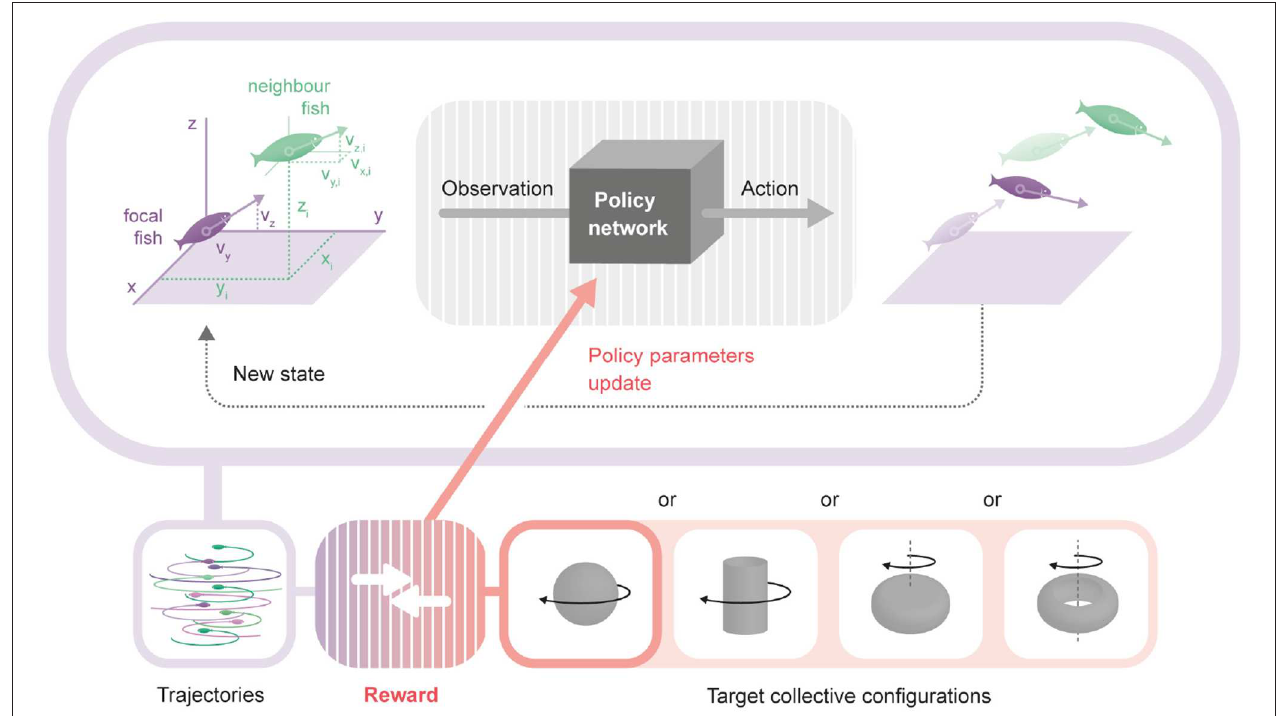
FIGURE 1 | Framework to obtain an interaction model producing a desired collective behavior. Upper: The policy network is a neural network that transforms the observation of an agent into its action. Its parameters are the same for all agents and chosen to produce a target collective behavior. For each focal fish (purple), the observation used to generate actions is formed by: the horizontal and vertical components of the focal fish, plus the three components of the relative position and three components of the absolute velocity of each of the neighbors. In the diagram, a single example neighbor fish is shown (green). From the observations of each focal fish, the policy network generates an action for each fish, modifying their heading and speed in the next time step according to the physics imposed for the environment. The new locations, velocities and orientations define a new state. Lower: Repeating the loop described above a number of times, we obtain a trajectory for each fish. We compare the trajectories with the selected desired configuration (rotating sphere, rotating tornado, rotating hollow-core mill and rotating full-core mill) producing a reward signal that it is used to change the parameters of the policy network.